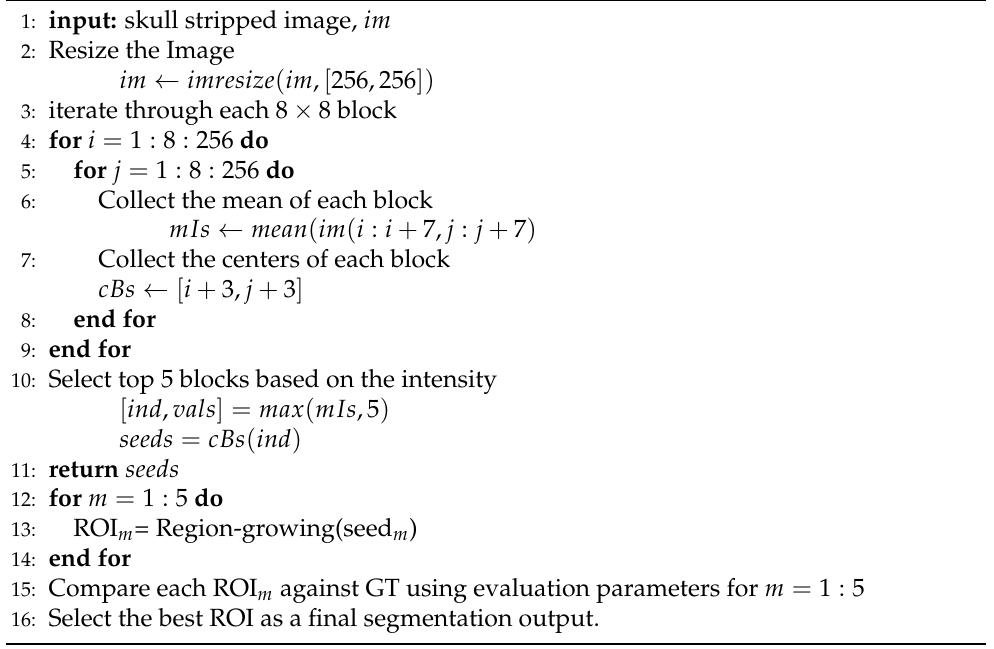
Algorithm 2 Enhanced Region Growing Segmentation for Brain Tumor